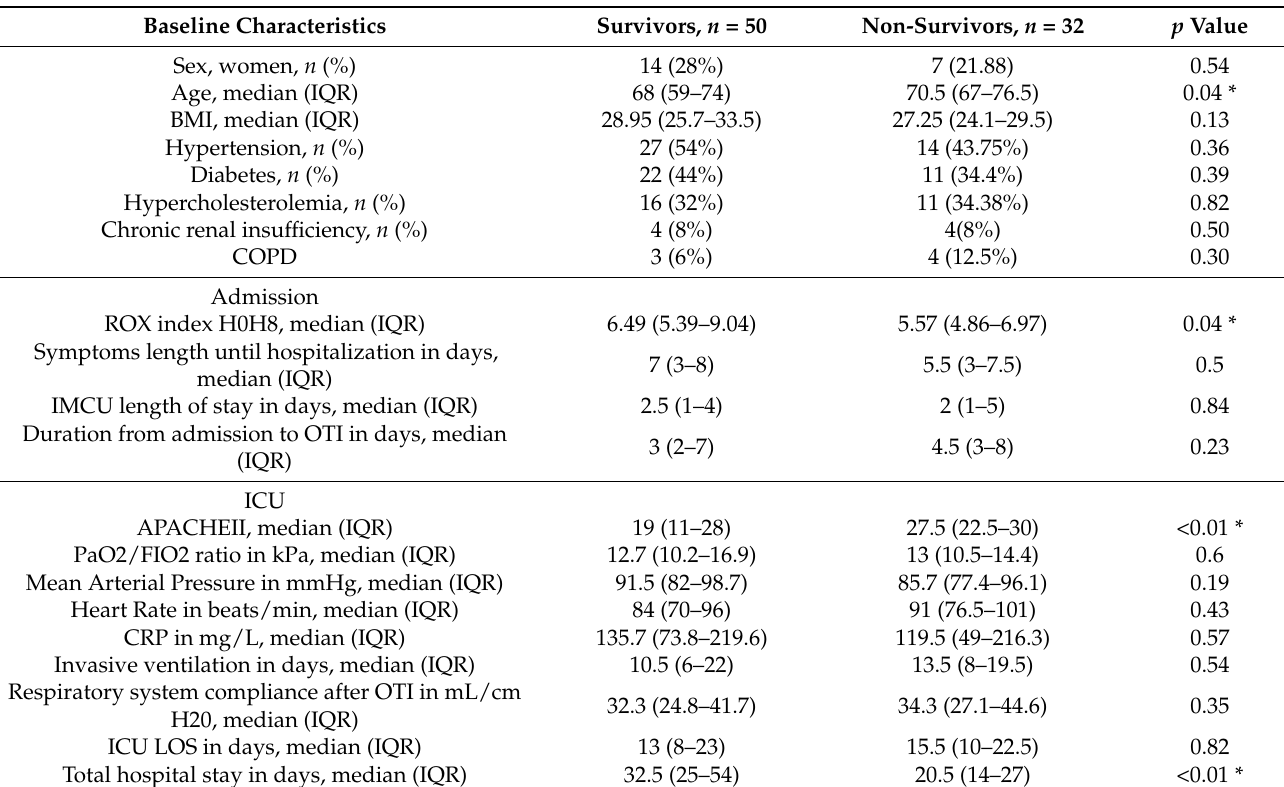
Table 2. Patients’ characteristics by survivor status.